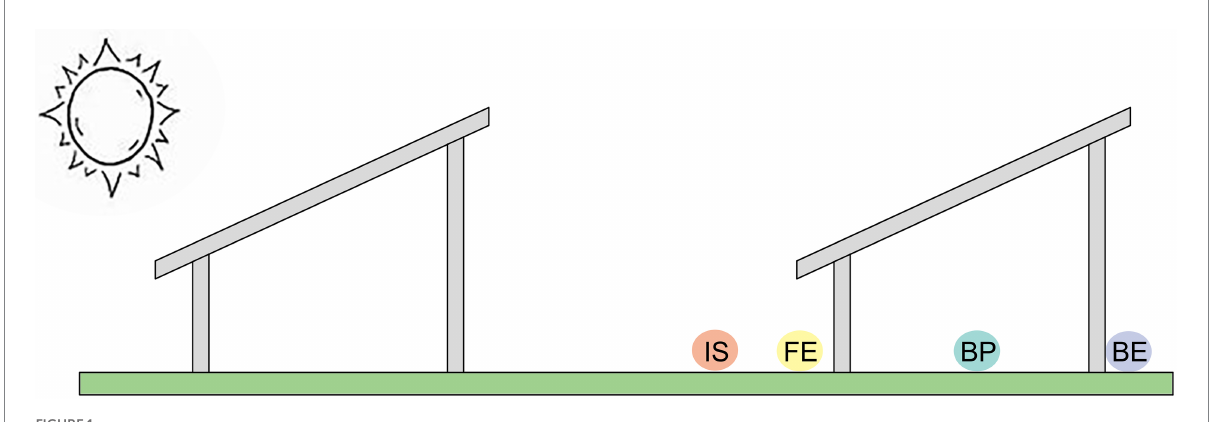
FIGURE 1 Different sites under the PV panels (FE: front edge of each panel, BP: beneath the center of each panel; BE: back edge of each panel; IS: the uncovered interspace adjacent to each panel; Control: the undisturbed grassland around the PV